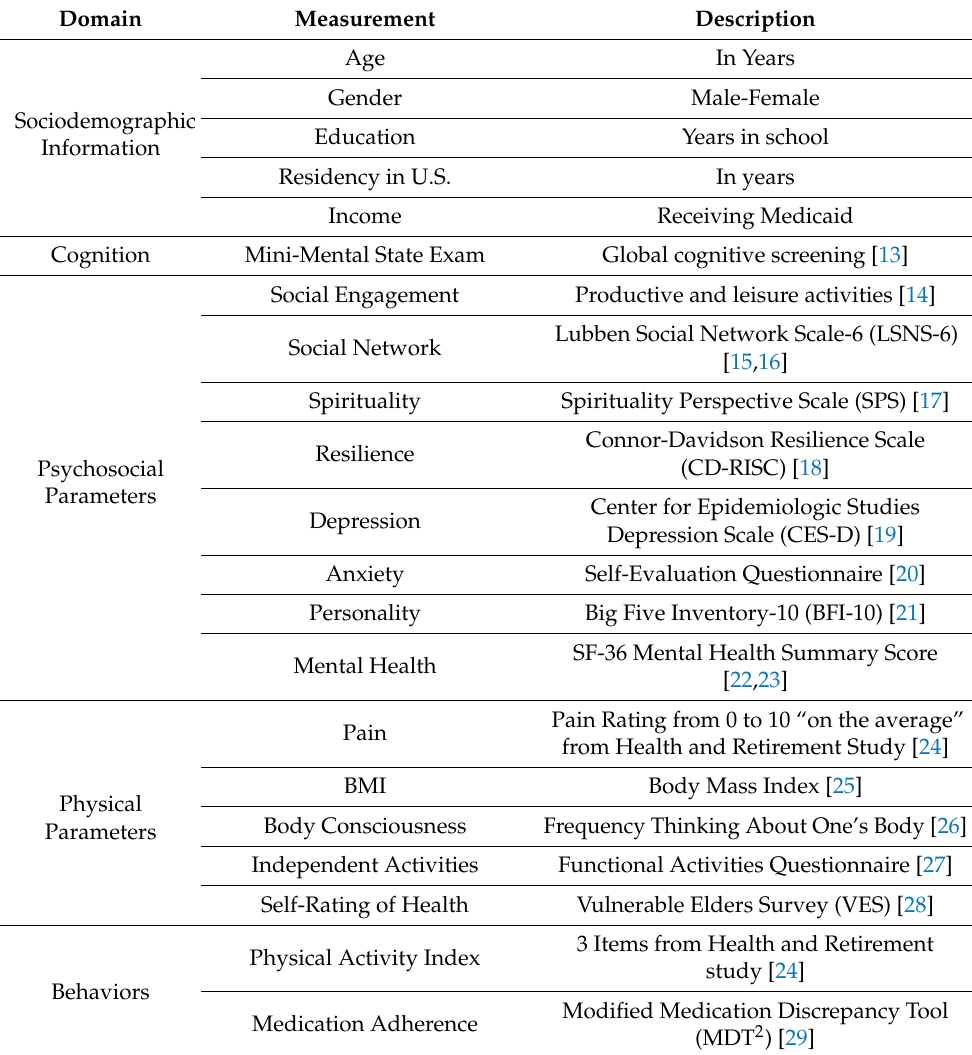
Table 1. Measures Included in Predictive